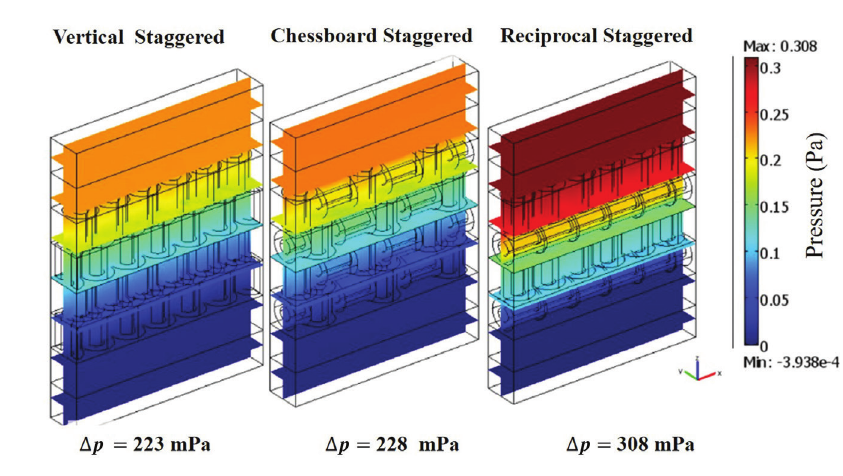
Fig. S7 – Pressure distribution profile